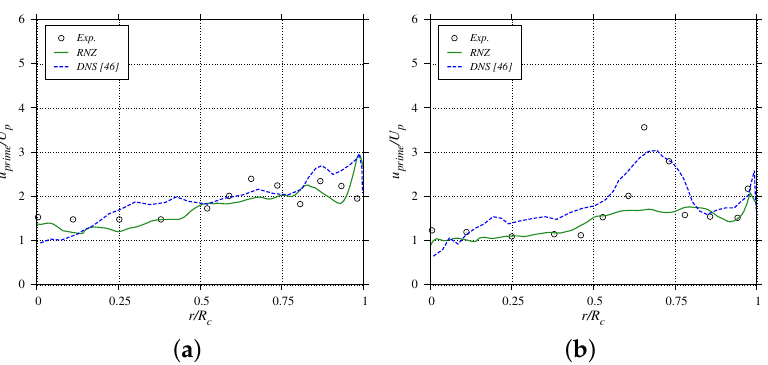
Figure 13. Radial distribution of the RMS axial velocity fluctuation u prime at θ = 144 ◦ : ( a ) z = − 20 mm; ( b ) z = − 30 mm.